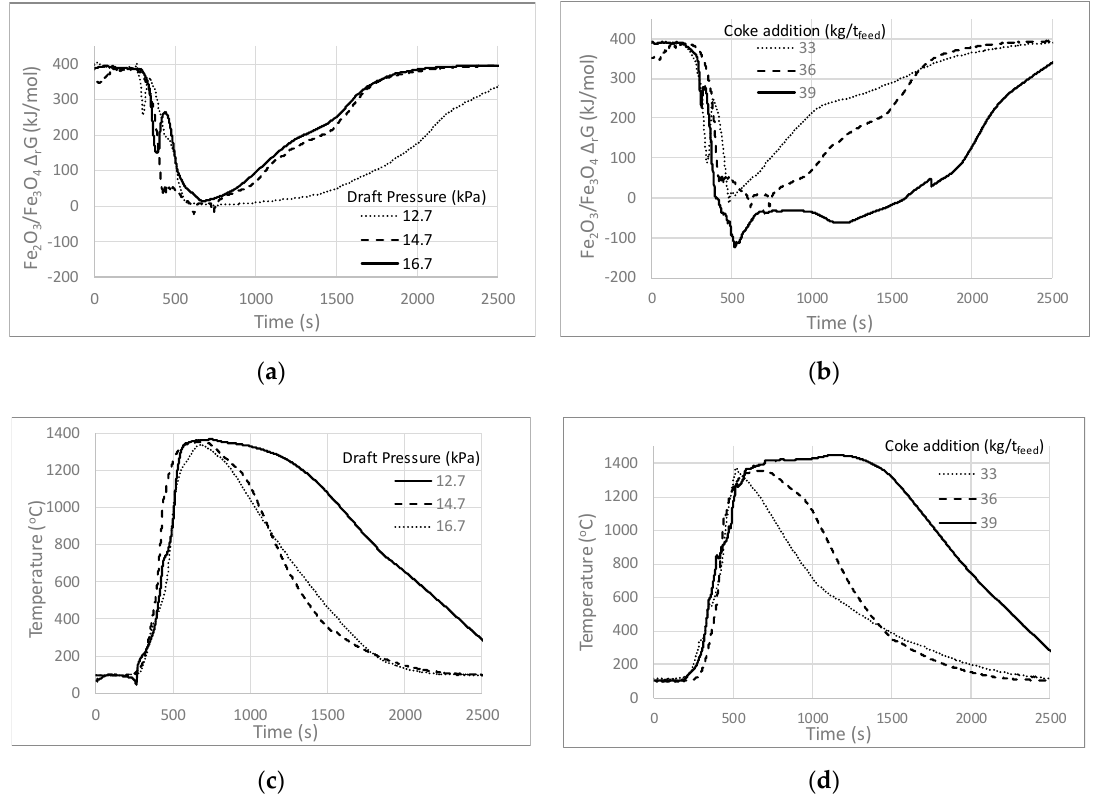
Figure 16. ( a , b ) The Gibbs free energy change for the reduction of hematite to magnetite based on the measured temperature and pressure within the sinterpot. ( c , d ) The temperature as a function of time measured at the midpoint within the sinterpot.